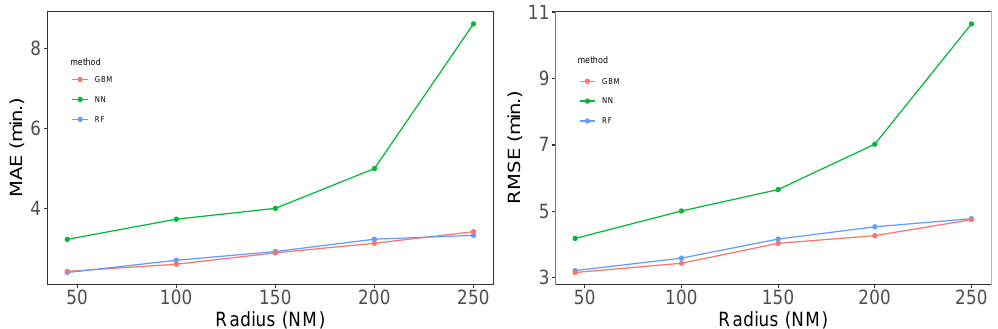
Figure 7. Line plot of MAE and RMSE depending on the radius by GBM, NN, and